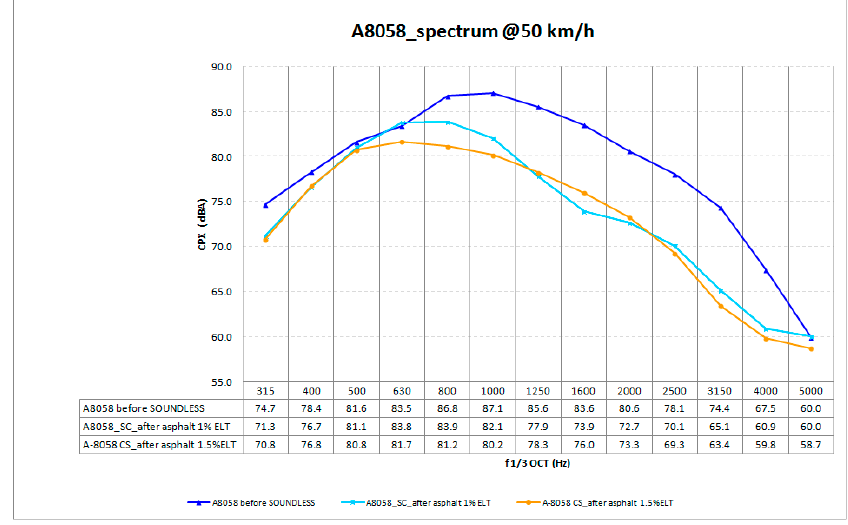
Figure 11. Average spectrum obtained on the A-8058 test track before and after paving the LIFE SOUNDLESS mixtures.